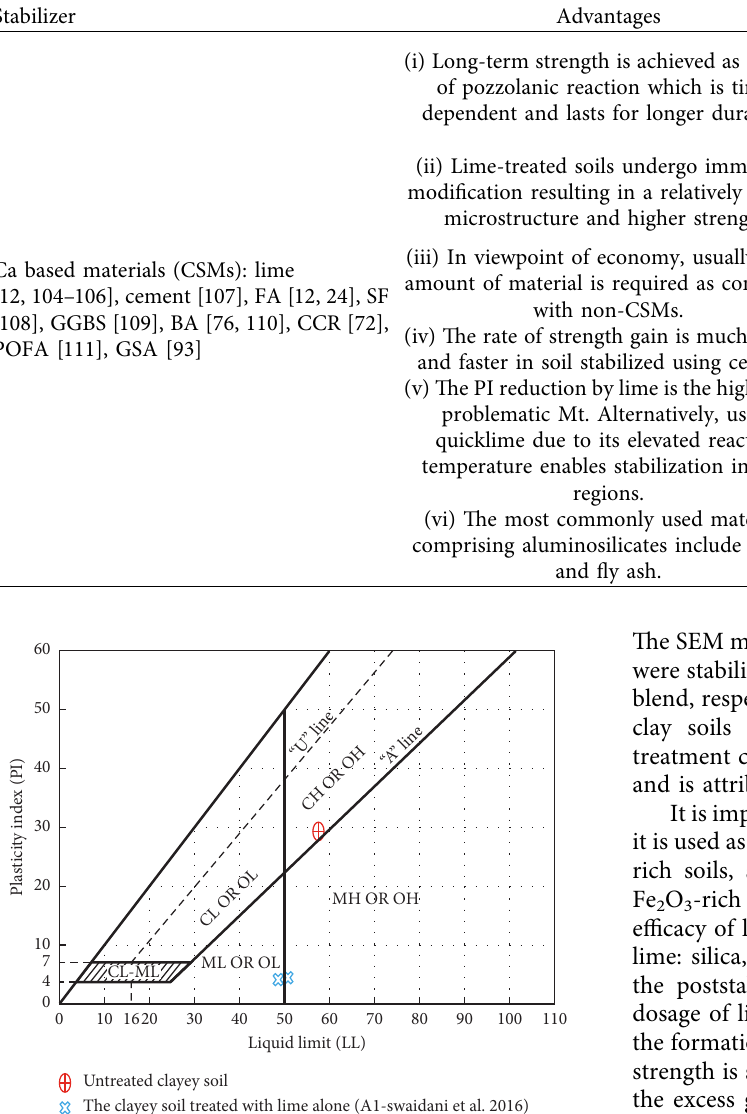
Figure 5: The main and interaction effects of lime in comparison with untreated soil, on Casagrande’s plasticity chart (with some modifications in the original figure) [112].